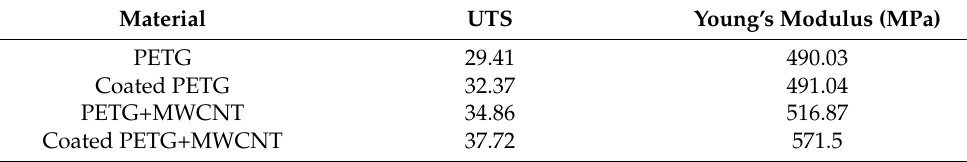
Table 2. Ultimate tensile strength (UTS) and Young’s modulus of various test